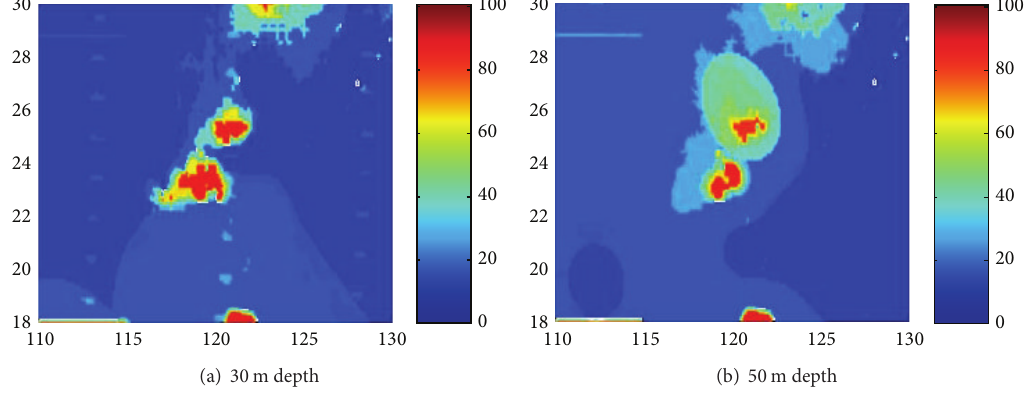
Figure 6: Safety situation